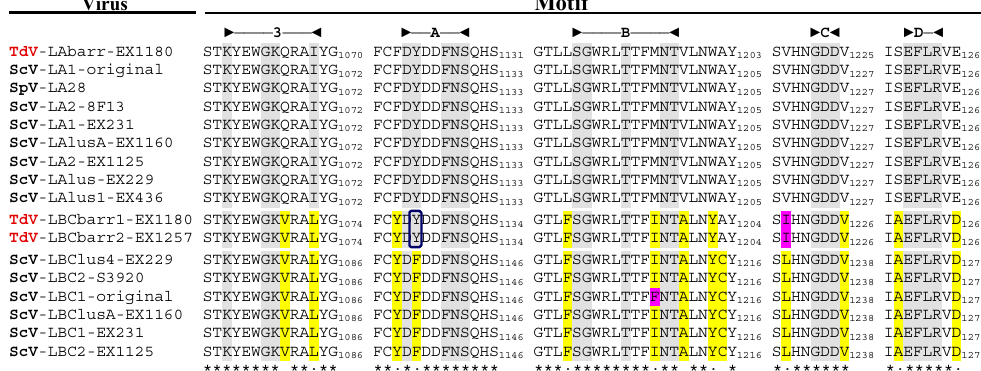
Figure 4. Conserved motifs in the Gag-Pol RdRp domain of L viruses from S. cerevisiae and T. delbrueclii . The extent of each domain is indicated in the top of the figure. The last amino acid of the stretch containing each motif is indicated to the right of the sequence. Asterisks (*) indicate identical amino acids; colons (:) and single dots (.) indicate conserved and semi-conserved amino acids, respectively. Conserved identical residues in all virus motifs are grey shaded. Different residues in LBC with respect to LA viruses are yellow shaded. Different residues for TdV-LBCbarr and ScV-LBC1-original are pink shaded. “Y” residue in motif A of TdV-LBCbarr that is coincident with LA viruses is indicated inside a square.